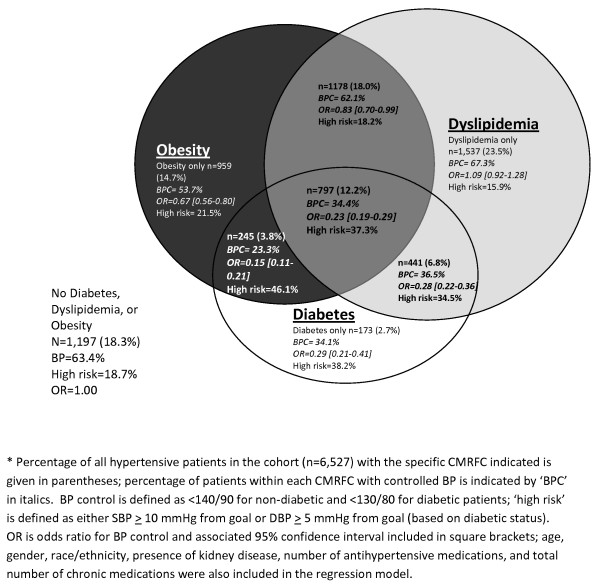
Venn diagram of cardiometabolic risk factor clusters (CMRFC) and association with BP control among hypertensive patient cohort (n = 6,527)*. Among the study hypertensive patient cohort, the co-occurrence of the cardiometabolic risk factors obesity, dyslipidemia, and diabetes are depicted. Obese hypertensive patients with diabetes had the lowest adjusted odds ratios of BP control.